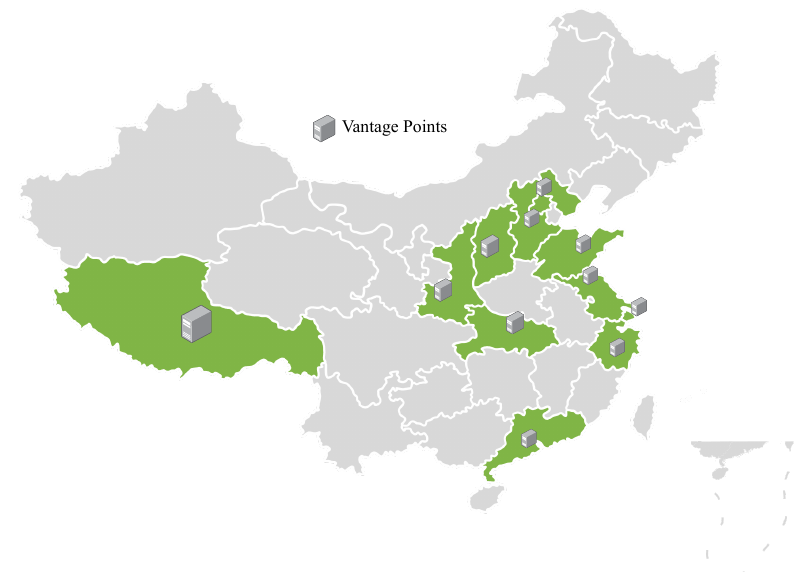
Figure 4. Geographical distribution of vantage points and DNS resolvers in